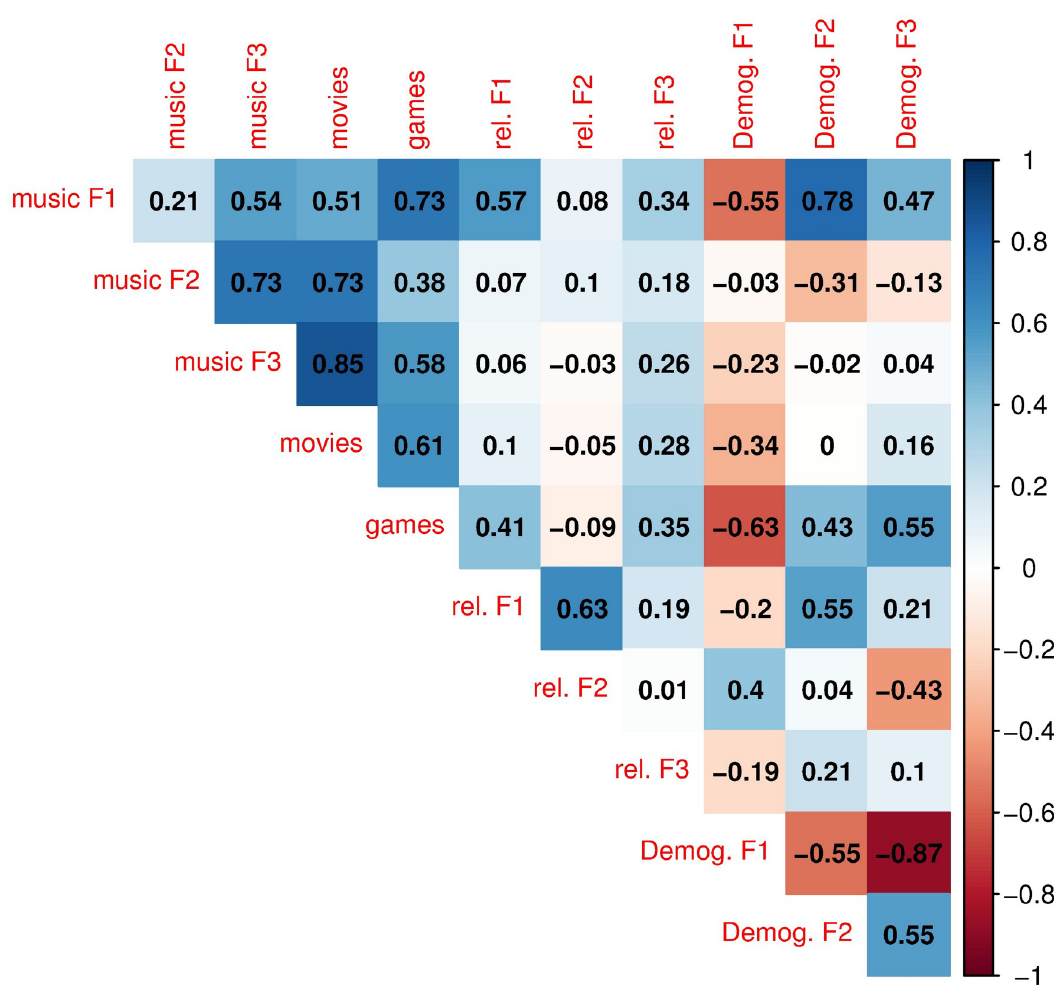
Fig 1. Correlation matrix of Facebook and demographic factor